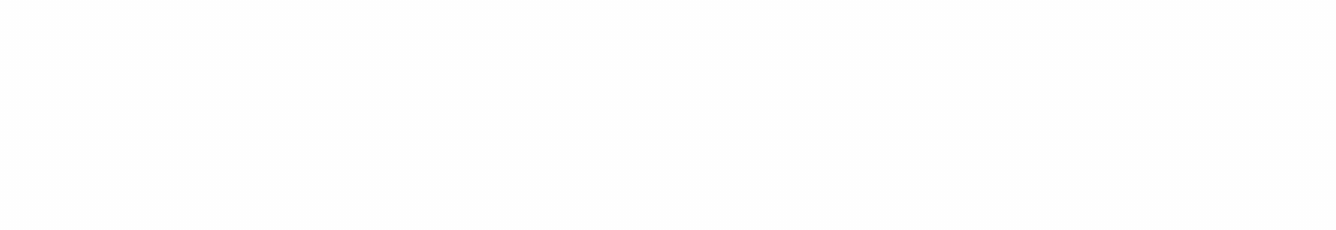
FIGURE 8 False-nearest neighbor embedding dimension calculation for the three prominent regions of instability in Fig.